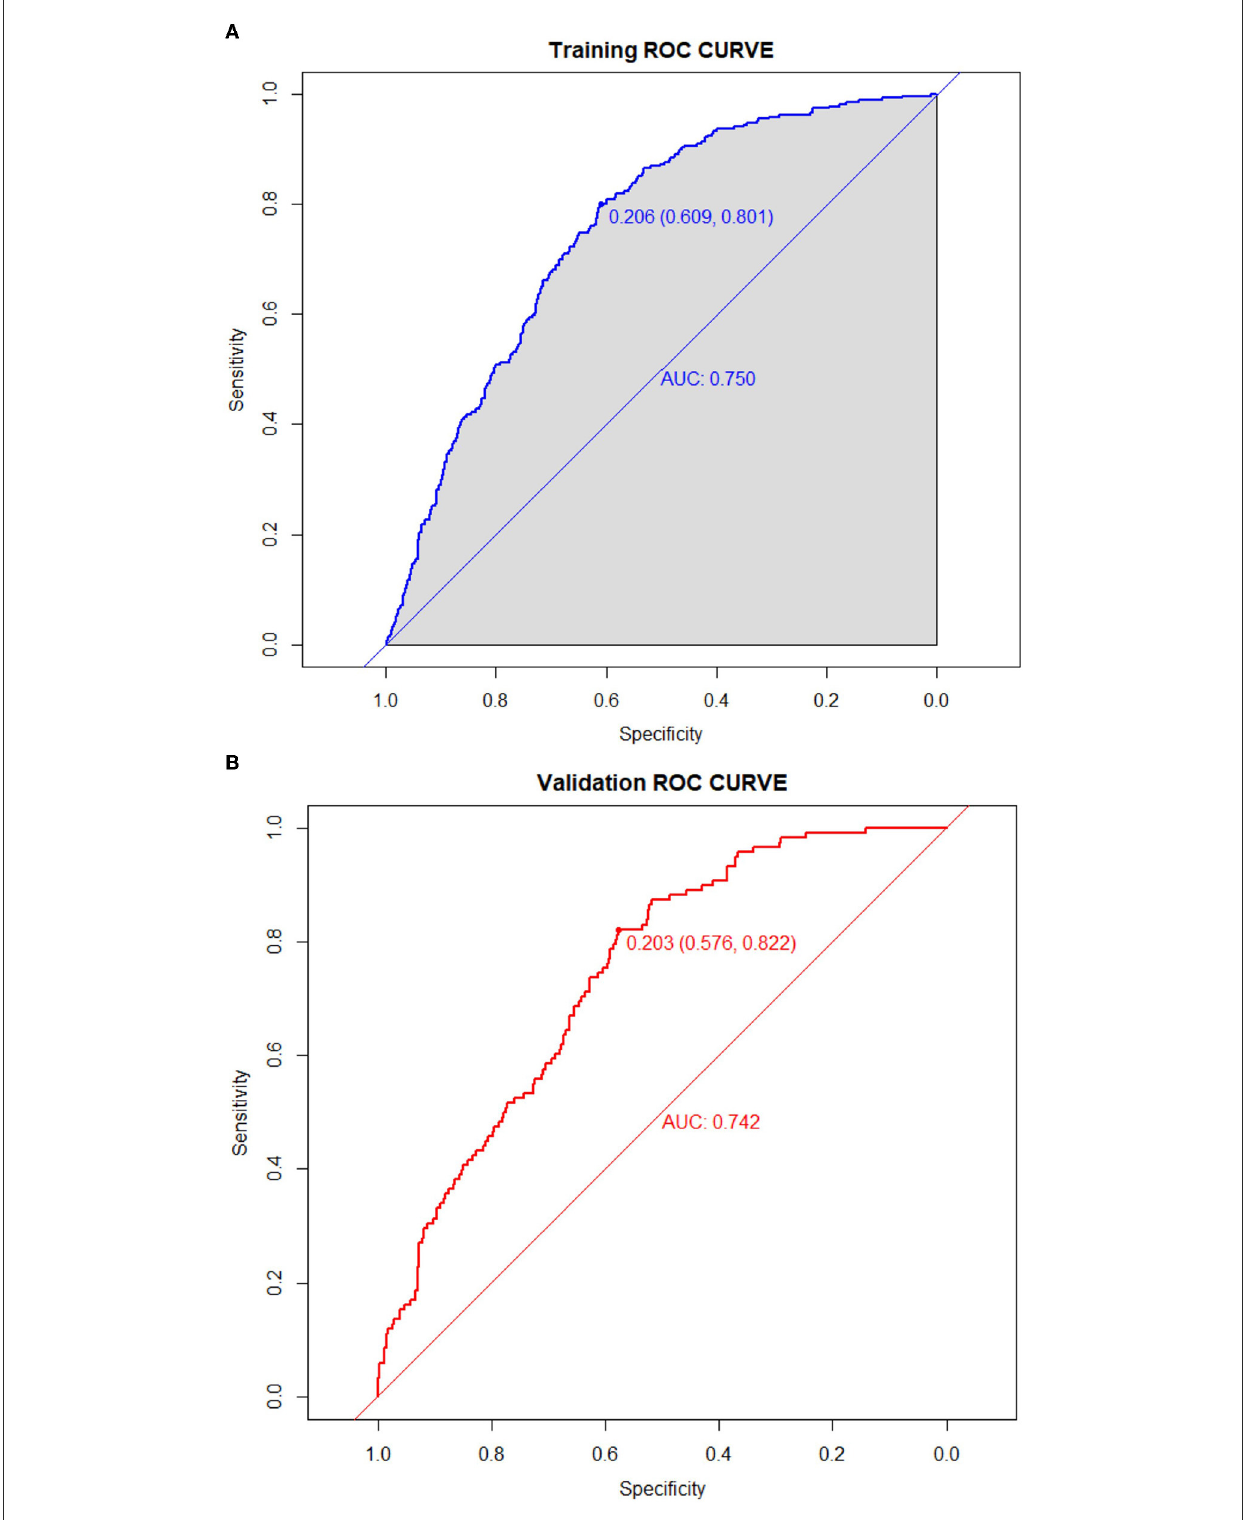
FIGURE4 Receiver operating characteristic curves of the model distinguishing PE from non-PE in the training (A) and validation (B)